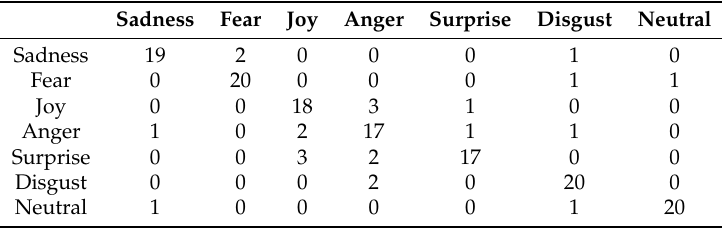
Table A1. P1 actor confusion matrix from the RekEmozio dataset in the second phase.